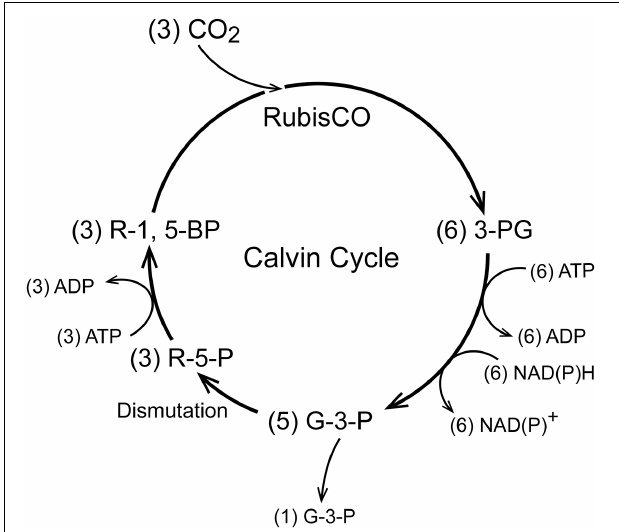
FIGURE 1 | A schematic representation of carbon fixation by the Calvin Cycle. The enzyme ribulose-1,5-bisphosphate carboxylase (RubisCO) adds CO 2 to ribulose-1,5-bisphosphate (R-1,5-BP) and splits the product into 2 molecules of 3-phosphoglycerate (3-PG). The 3-PG is then reduced to glyceraldehyde-3-phosphate which dismutates to regenerate the 5-carbon ribulose-5-phosphate (R-5-P). Phosphorylation of R-5-P regenerates R-1,5-BP for the next cycle. Only one carbon is added per turn of the cycle. Three turns of the cycle are required for a net increase of one G-3-P. The number of molecules involved in synthesis of one G-3-P is given in parentheses. Although a total of 6 G-3-P are formed, five of these are dismuted to produce the ribulose sugars required for maintaining cycle function. FIGURE 2 | A schematic for operation of the Calvin Cycle in early autotropes.